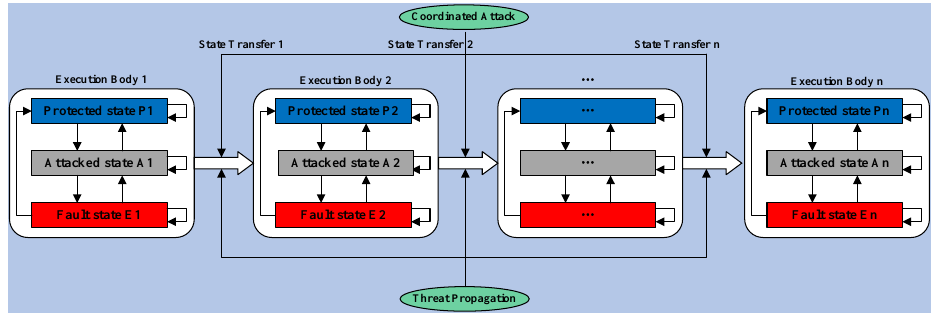
Figure 8. Common vulnerability exploitation.